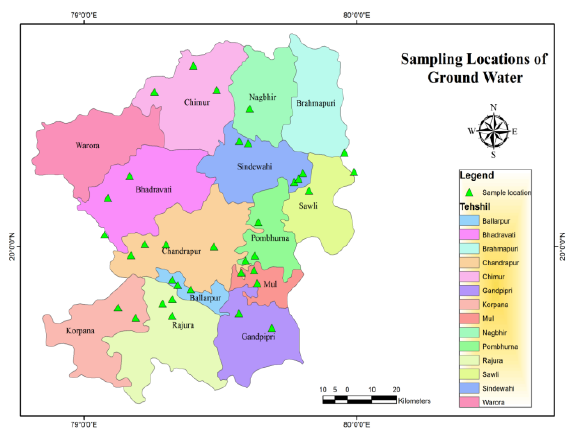
Figure 2. Groundwater sampling